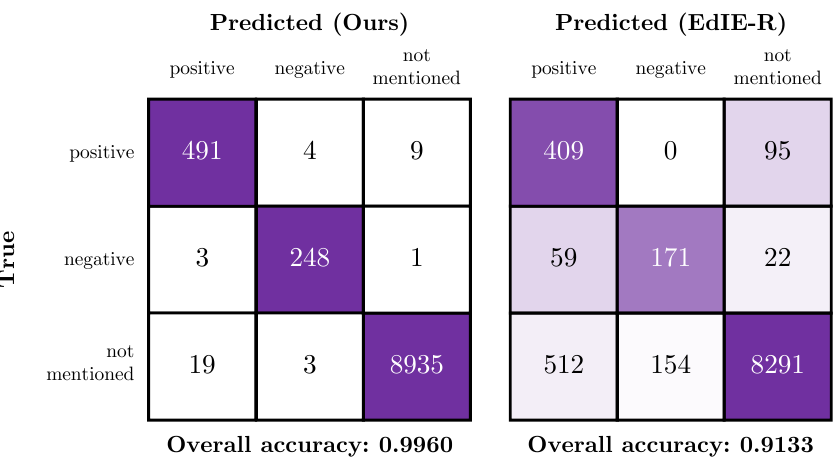
Figure 10. Confusion matrices showing the performance of our model ( left ) and the EdIE-R ( right ) on the independent test data across the certainty class subset of positive , negative and not mentioned